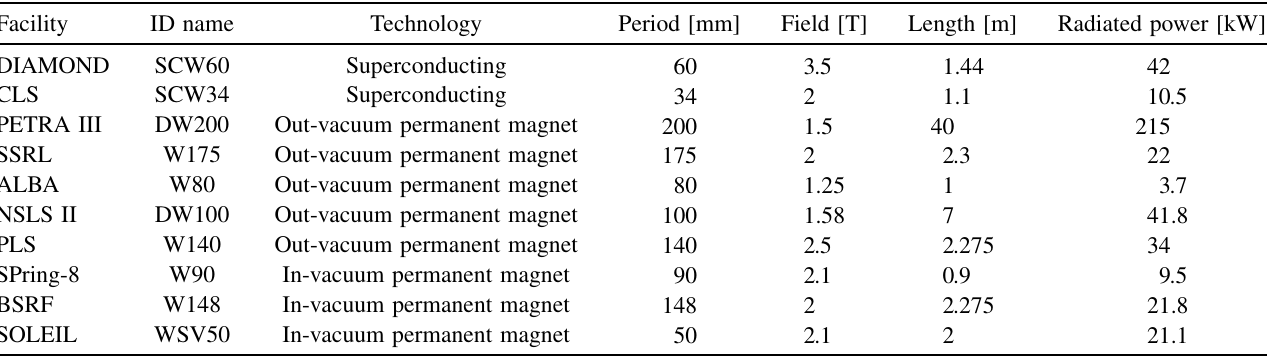
TABLE I. Characteristics of existing and designed moderate field